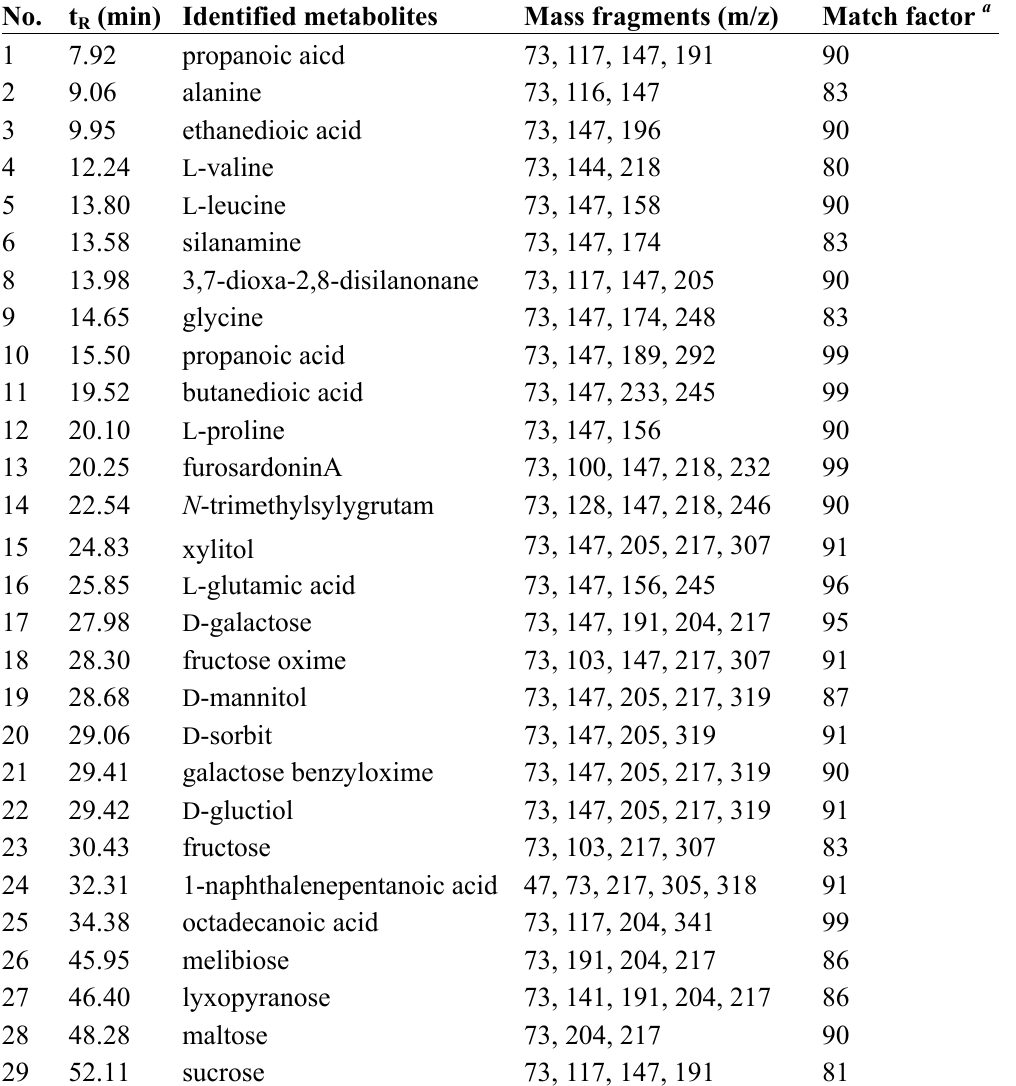
Table 3. Retention times, mass fragments, and match factors of detected metabolites in R. glutinosa by